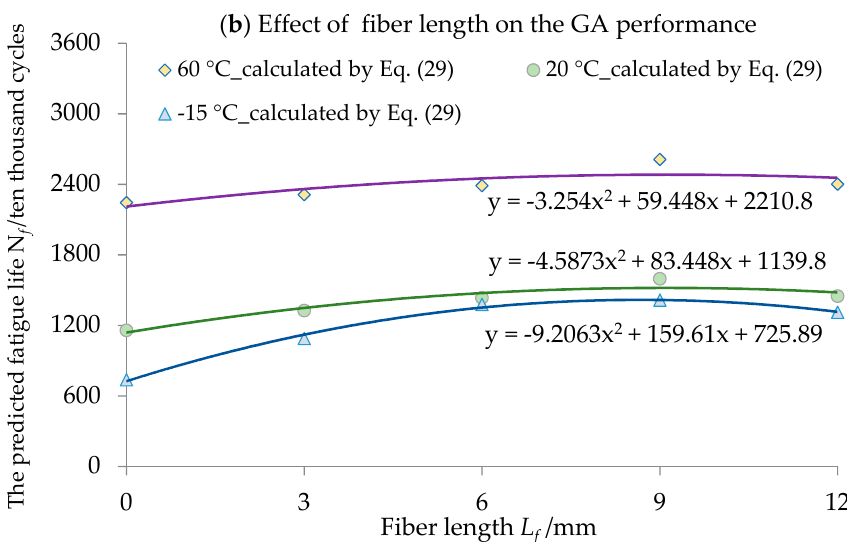
Figure 4. Comparison between predicted and measured fatigue life for different temperatures and fiber lengths (tested under standard axle load, BZZ-100) (unit: 10,000 cycles). ( a ) Effect of fiber length on the GA performance (the theoretically predicted value and test results); ( b ) Effect of fiber length on the GA performance.